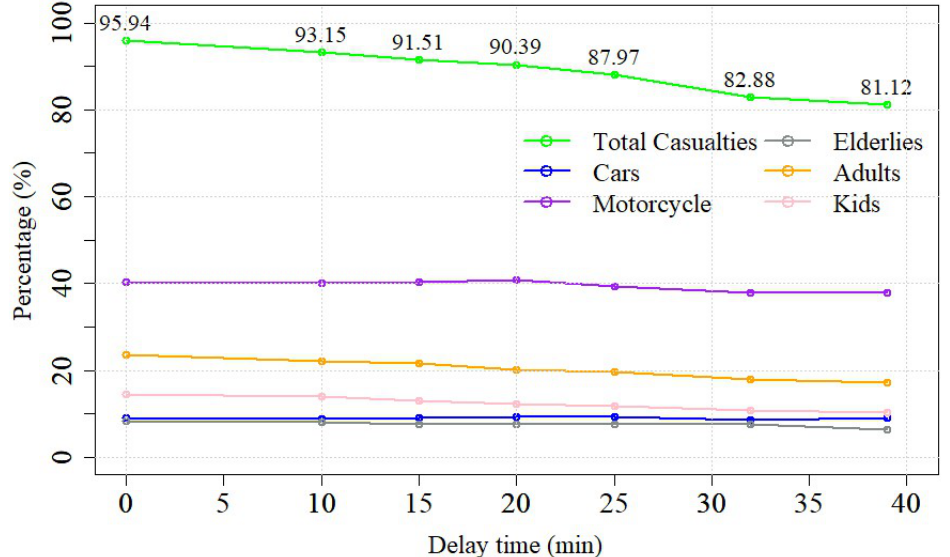
Figure 8. Resulting evacuees (%) depending on the delay time, τ (min).